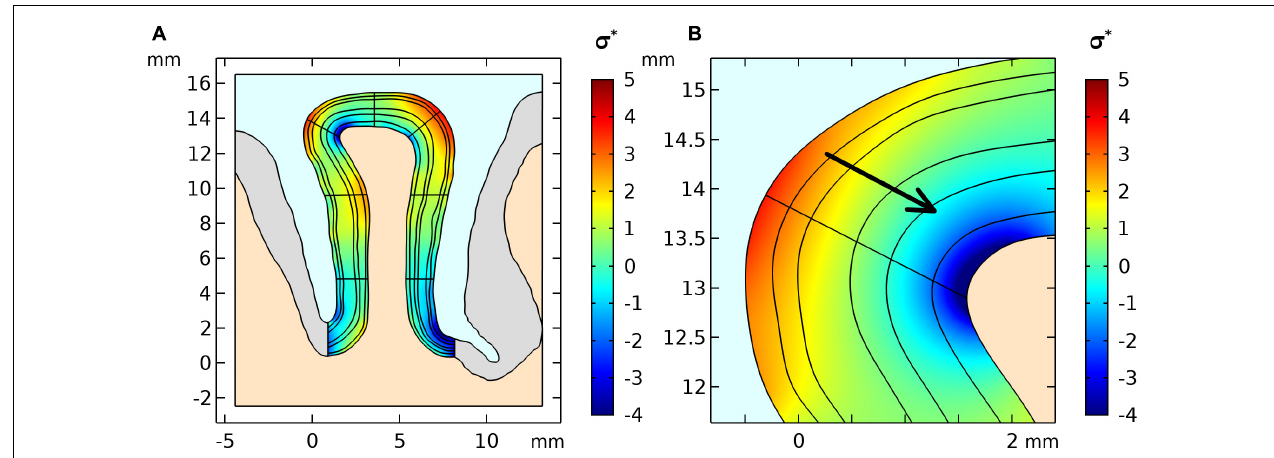
FIGURE 2 | (A) Stress distribution results of the first simulation step of the geometry and (B) a zoomed region where positive curvature results in a positive stress gradient across layers. The stress was normalized by the stiffness value µ of the GM.